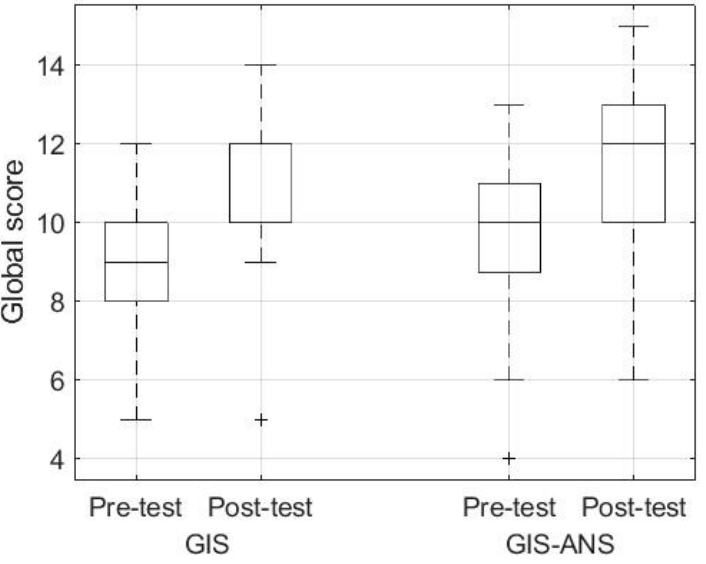
Figure 4. Global STAT scores by curricular unit in the pre-test and post-test.